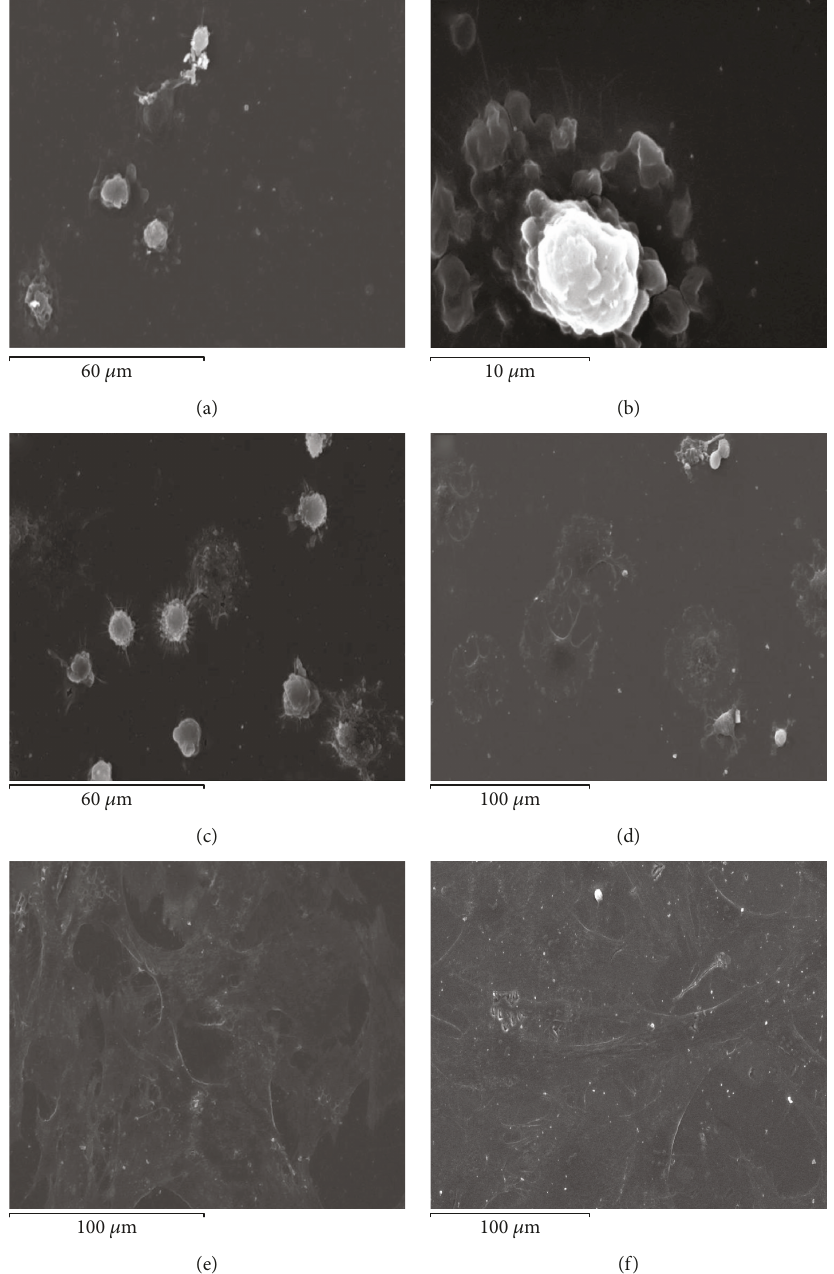
Figure 2: Morphological adaptation of MSCs on polished Ti. (a) Cells with a prominent nucleus and circumferentially spread cell membrane at 5 min post seeding. At (b) 15 min and (c) 30 min, cellular spreading had increased with some cells appearing comparatively rounded by this time. (d) By 1 h, most cells displayed a uniform circumferential spread over the surface. By (e) 3 h and (f) 24 h, cells had adapted an irregular and stretched polygonal